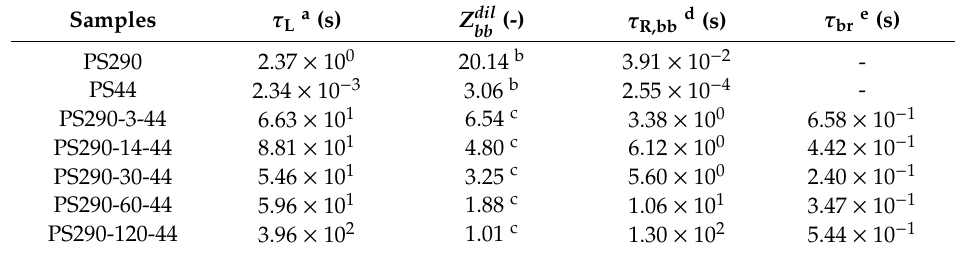
Table 3. Characteristic relaxation times of model comb PS set at T ref = 180 ◦